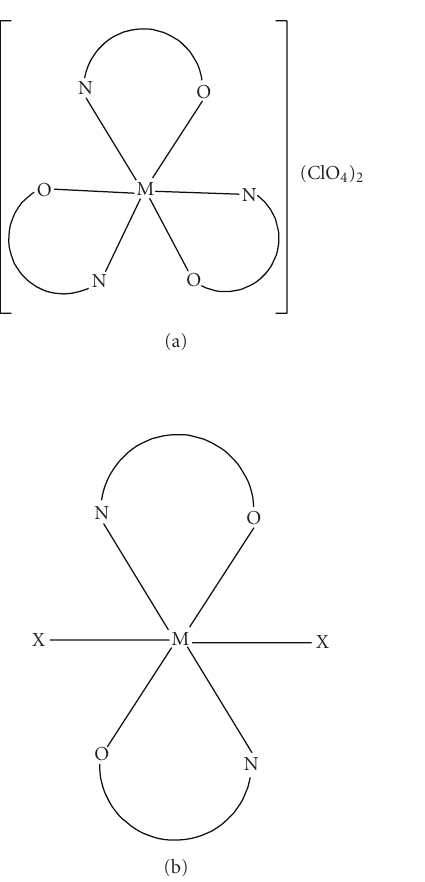
and test plates, respectively (Table